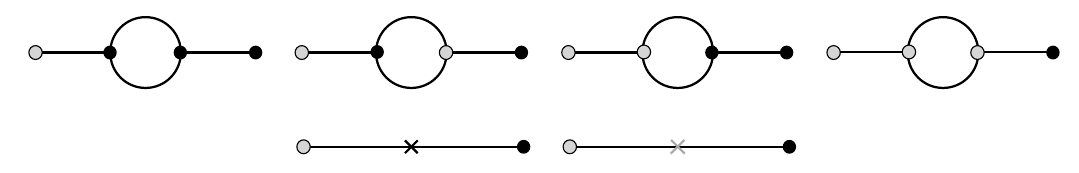
Figure 2 . (Top) Connected one-loop contributions to the two-point correlation function in a λφ 3 theory. (Bottom) The corresponding δ m and/or δ r counterterm